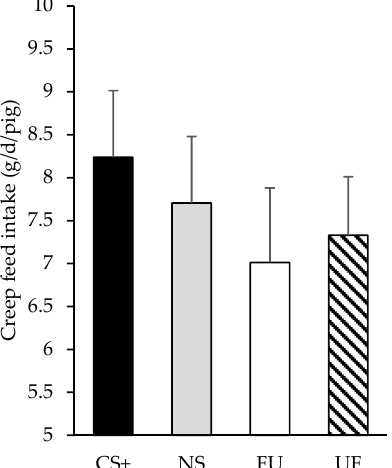
Figure 3. Daily intake of creep feed diet by piglets (days 14 to 18) who were offered (from days 10 to 20 of the suckling period) either the same flavor in their diet than their mothers in the late-gestation (90-114d; CS + ), a different flavor (NS), an unflavored creep feed diet (FU), or a flavored creep diet, but born from a mother that was fed an unflavored maternal diet (UF). Results expressed as Least Square means ±